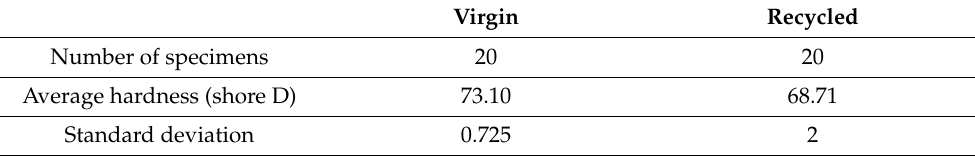
Table 7. Shear strength of virgin versus recycled polylactic acid 3D printed specimens. Virgin Recycled Number of specimens 20 20 Average shear yield strength (MPa) 28,448 29,253 Standard deviation 0.69 2.00 Table 8. The hardness of virgin versus recycled polylactic acid 3D printed specimens. Virgin Recycled Number of specimens 20 20 Average hardness (shore D)